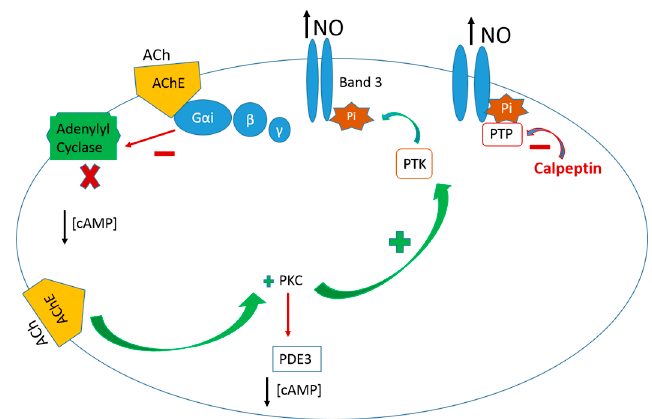
Figure 2. Schematic representation of the AChE–ACh active complex transduction pathway of the NO efflux from human erythrocytes supported by in vitro studies, as explained in the text [17,61,64–66].